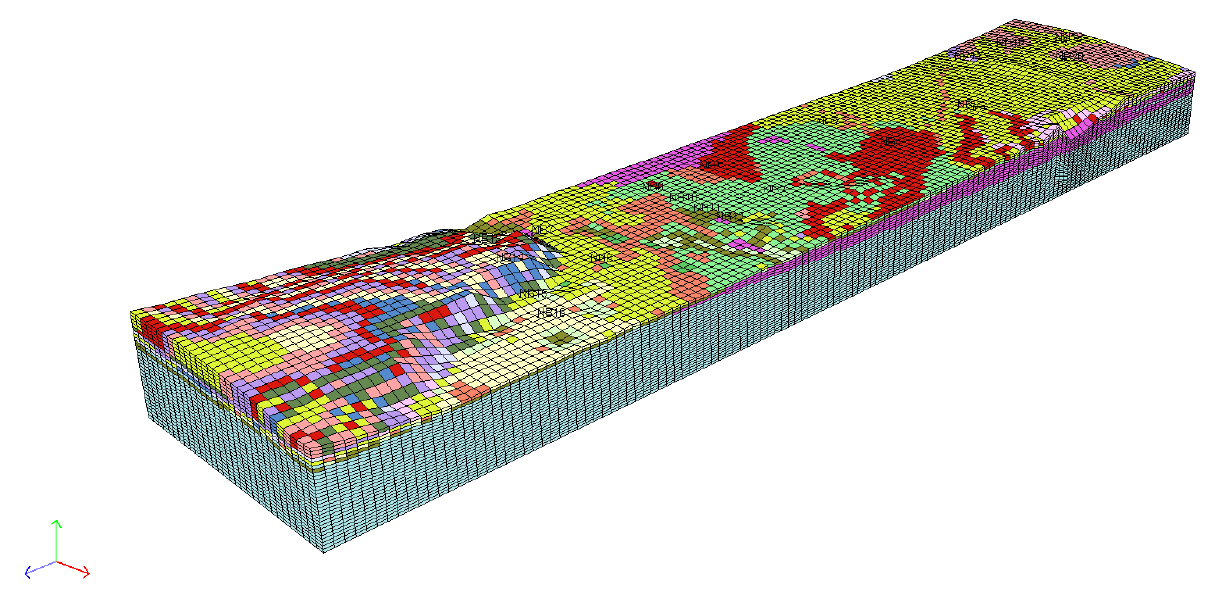
Figure 6: 3D substrate reconstruction with finite element mesh.